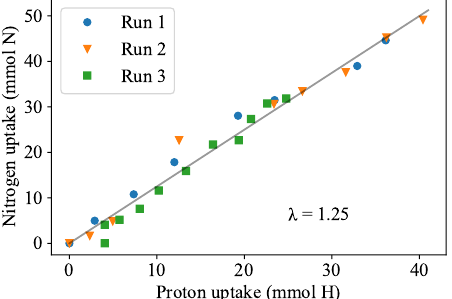
Figure 2. Results from batch experiments in 10% Hoagland’s medium where the pH was controlled at 6.5. The relationship between absorbed nitrogen and dosed protons ( λ ) was determined to be the same value of 1.25 mol N · mol − 1 H as indicated by the common slope.